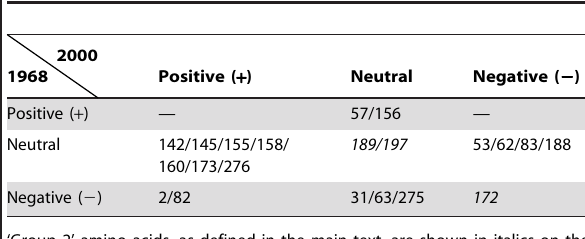
Table 1. Amino acids of the HA1 sequence involved in changes of charge state when comparing 1968, 1985 and